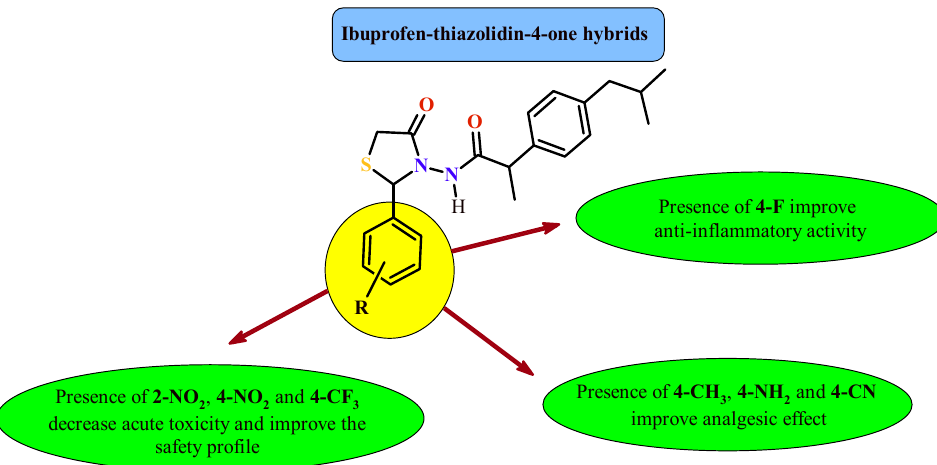
Figure 26. The influence of benzene ring substitution for activity potential of ibuprofen-thiazolidin-4-one hybrids.